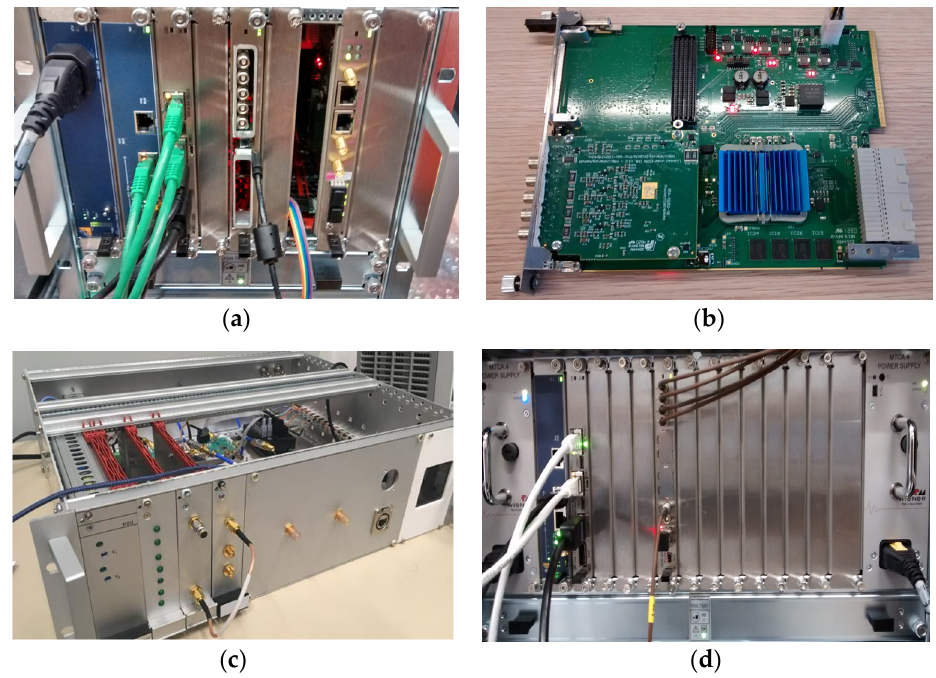
Figure 15. Hardware employed in the LLRF system. ( a ) Mini- μ TCA crate for system development. ( b ) Self-made multipurpose AMC card. ( c ) Frequency synthesizer to generate the LO and synchronization signals. ( d ) Final full-size μ TCA crate to be used in the facility.